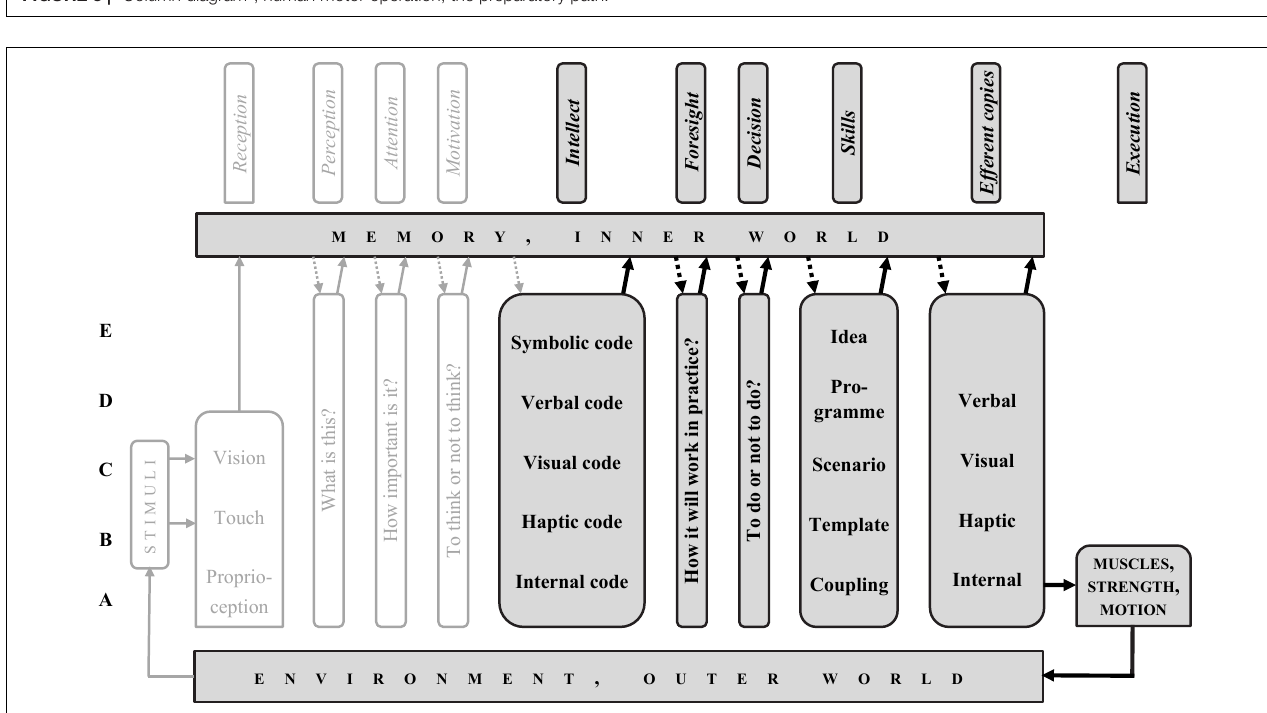
FIGURE 3 | “Column diagram”; human motor operation, the preparatory path.